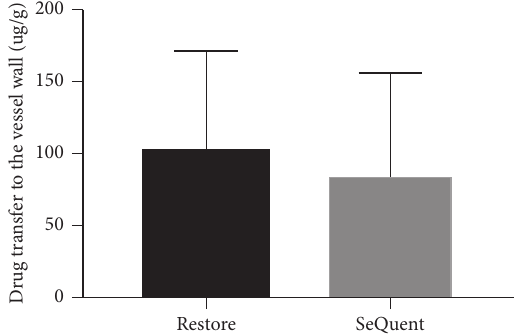
Figure 5: Paclitaxel transfer to the vessel wall in vivo experiments mimic coronary balloon angioplasty. Drug transfer to the vessel wall was comparable between Restore ® and SeQuent ® Please group (101.3 ± 63.5 μ g/g versus 83.9 ± 65.5 μ g/g, p � 0 .